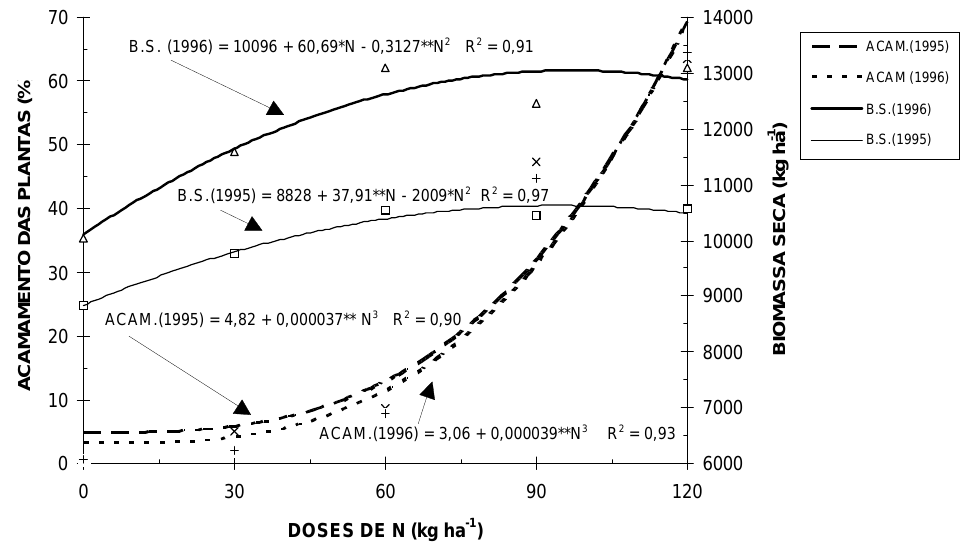
Figura 1. Acamamento das plantas (ACAM.) e biomassa seca (B.S.) de trigo influenciados pelas doses de nitrogênio (N) em cobertura, em 1995 e 1996.